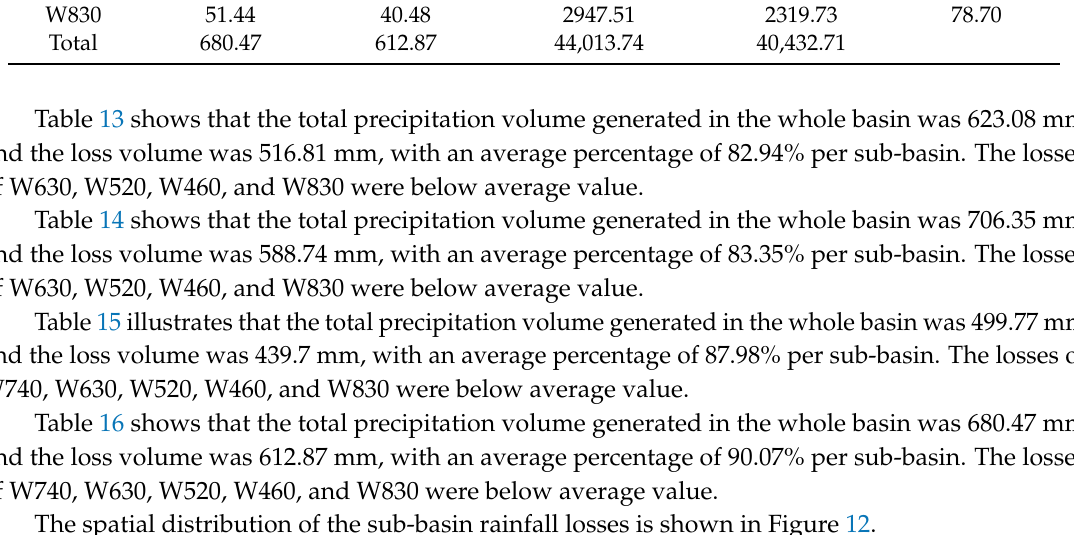
Table 16. Basin losses of 2012.